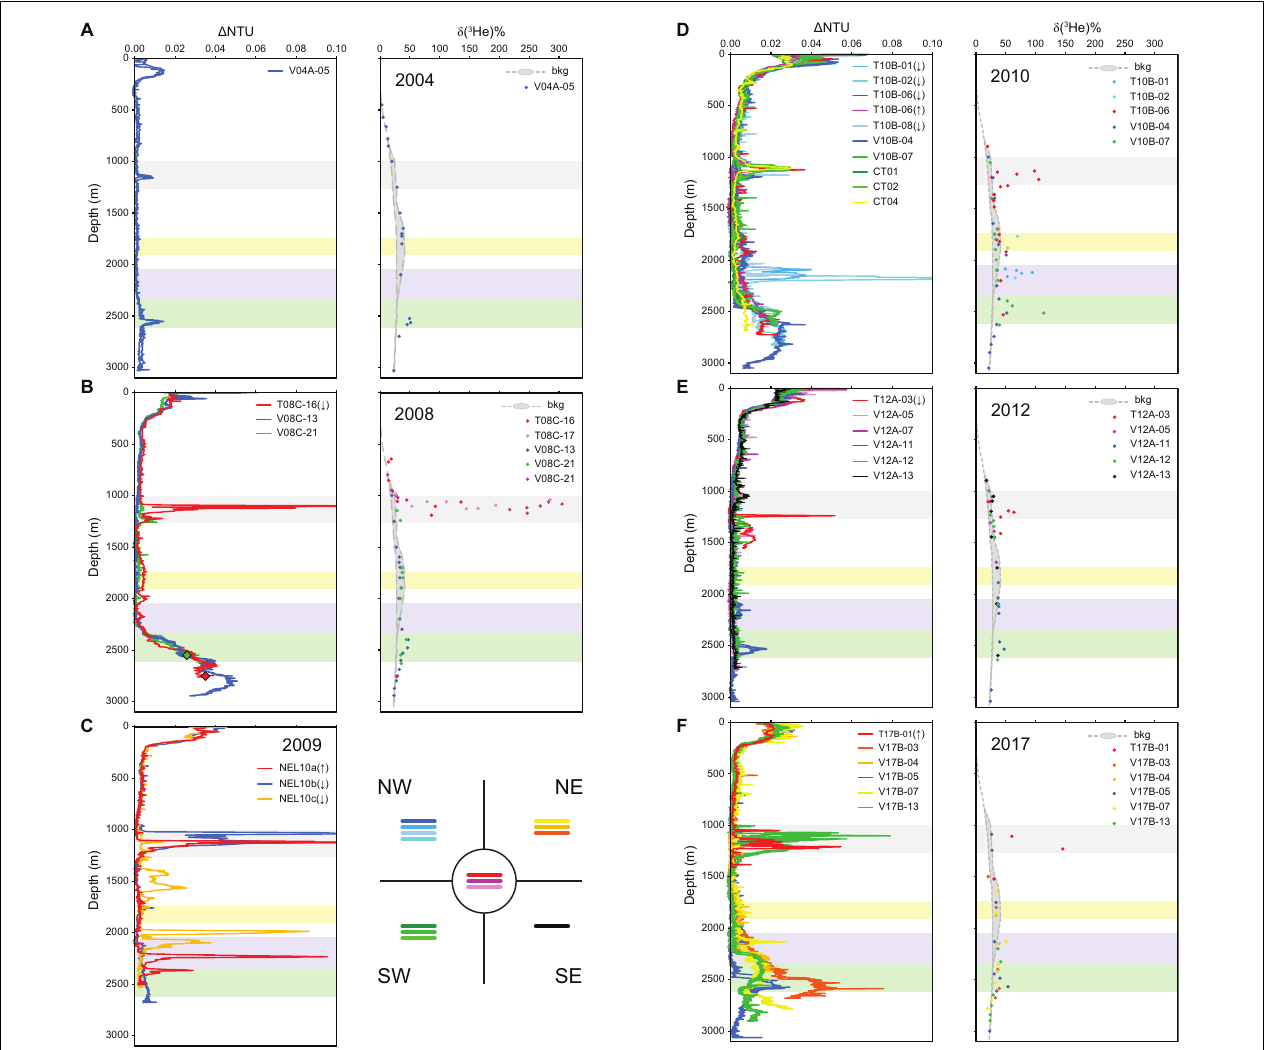
FIGURE 3 | (cid:49) NTU and δ ( 3 He)% profiles for all years. δ ( 3 He)% background (gray) shows the range of values typical of the regional “Samoa plume” of Lupton et al. (2004). Color bands show depth ranges where hydrothermal plumes from the summit of West Mata (gray) and the North Mata volcanoes are found (from Figure 4 : yellow = Tolu, blue = Ua, and green = Fa/Ono/Fitu). (A) (cid:49) NTU and δ ( 3 He)% profiles from 2004; (B) (cid:49) NTU and δ ( 3 He)% profiles from 2008, diamond symbols show locations of samples shown in Figure 6 ; (C) (cid:49) NTU and δ ( 3 He)% profiles from 2009; (D) (cid:49) NTU and δ ( 3 He)% profiles from 2010 (May); (E) (cid:49) NTU and δ ( 3 He)% profiles from 2012; (F) (cid:49) NTU and δ ( 3 He)% profiles from 2017. No δ ( 3 He)% is available for 2009, so 3c (right side) shows the color scheme used in all years to indicate the relative proximity or direction of each profile from West Mata (red/pinks = closest to West Mata summit, blues = NW quadrant, greens = SW quadrant, black = SE quadrant, yellow/gold/orange = NE